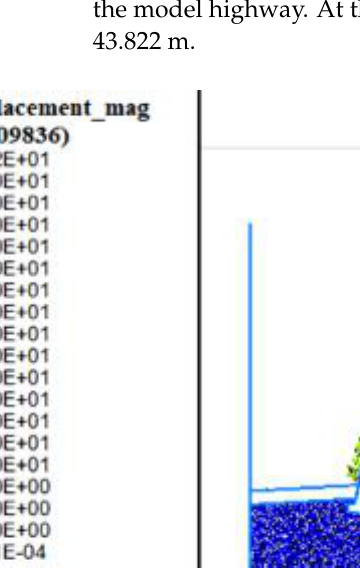
Figure 11. Displacement diagram of complete failure of the slope.